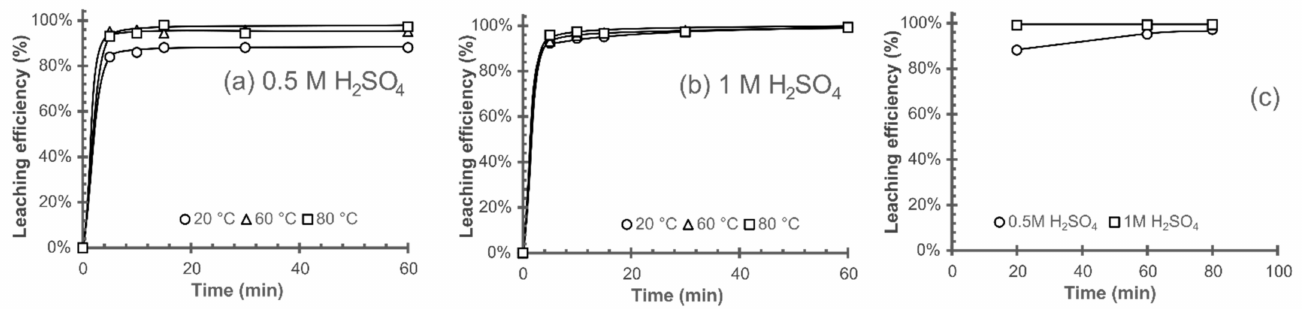
Figure 5. Effect of temperature on Zn leaching efficiency over time at 20 ◦ C, 60 ◦ C and 80 ◦ C, in ( a ) 0.5 M and ( b ) 1 M H 2 SO 4 solution, L:S ratio of 40 and constant stirring speed of 300